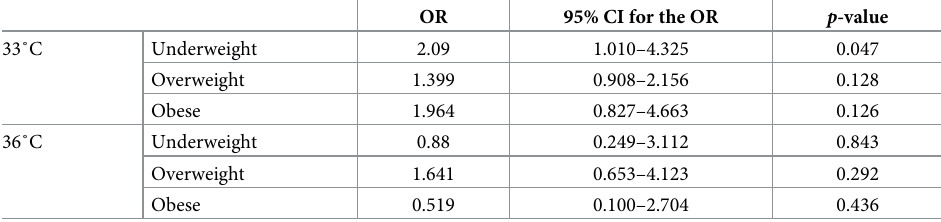
Abbreviations : OR odds ratio, CI confidence interval. �